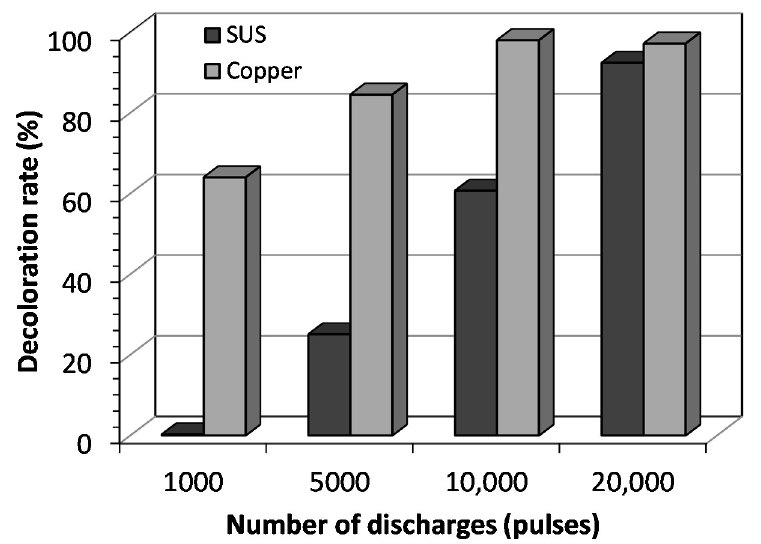
Figure 5. Decomposition of methyl orange dye as a water pollutant model compound [38].